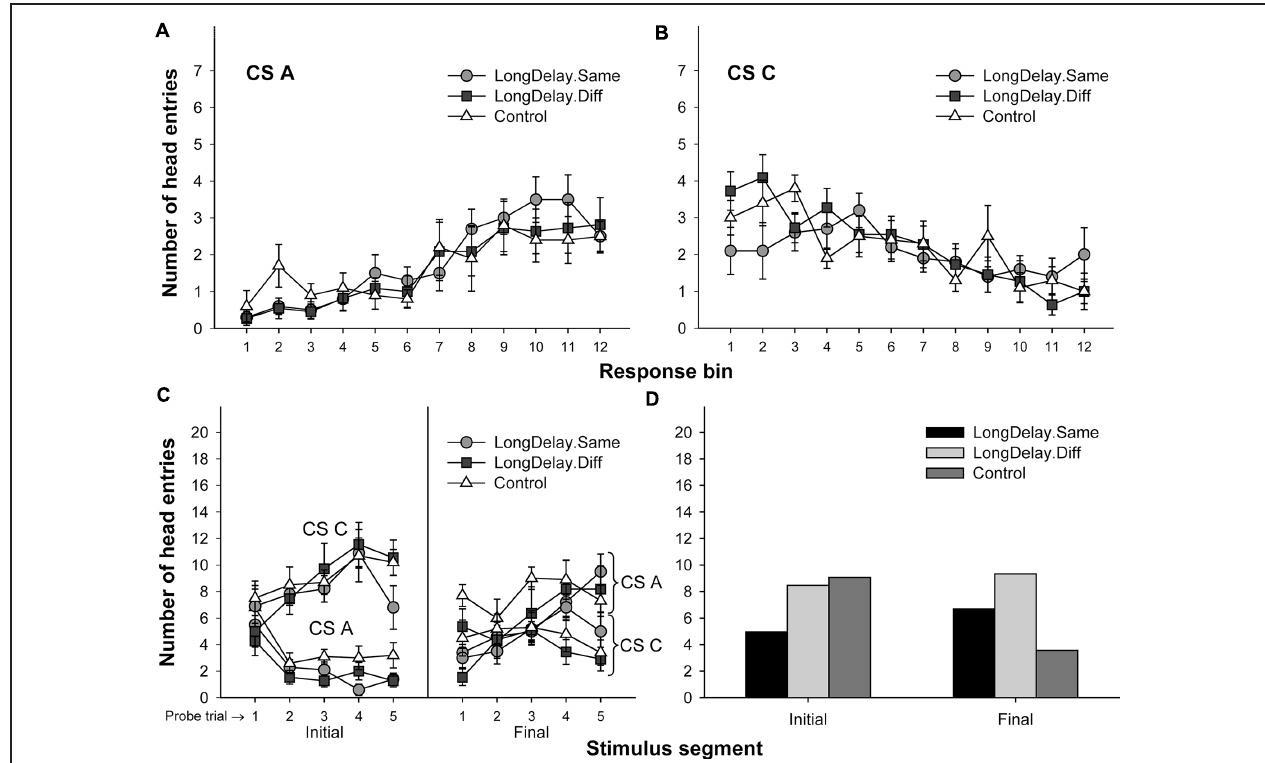
FIGURE 6 | Results of Experiment 2. The top panels represent responding to CSs A (A) and C (B) during each of the 12 5-s bins of the last probe trial of long delay conditioning training. US delivery was expected at 55 s (Bin 11) or 10 s (Bin 2) after onset of CSs A and C, respectively. (C) Presents responding to the initial (average of Bins 1–3) and final (average of Bins 10–12) segments of CSs A and C during the five probe trials of long delay conditioning training. (D) Presents responding to the initial and final segments of CSs A (Group LongDelay) and B (Group Control) during the probe trial of retardation training, adjusted for overall rates of responding during retardation training. See text for